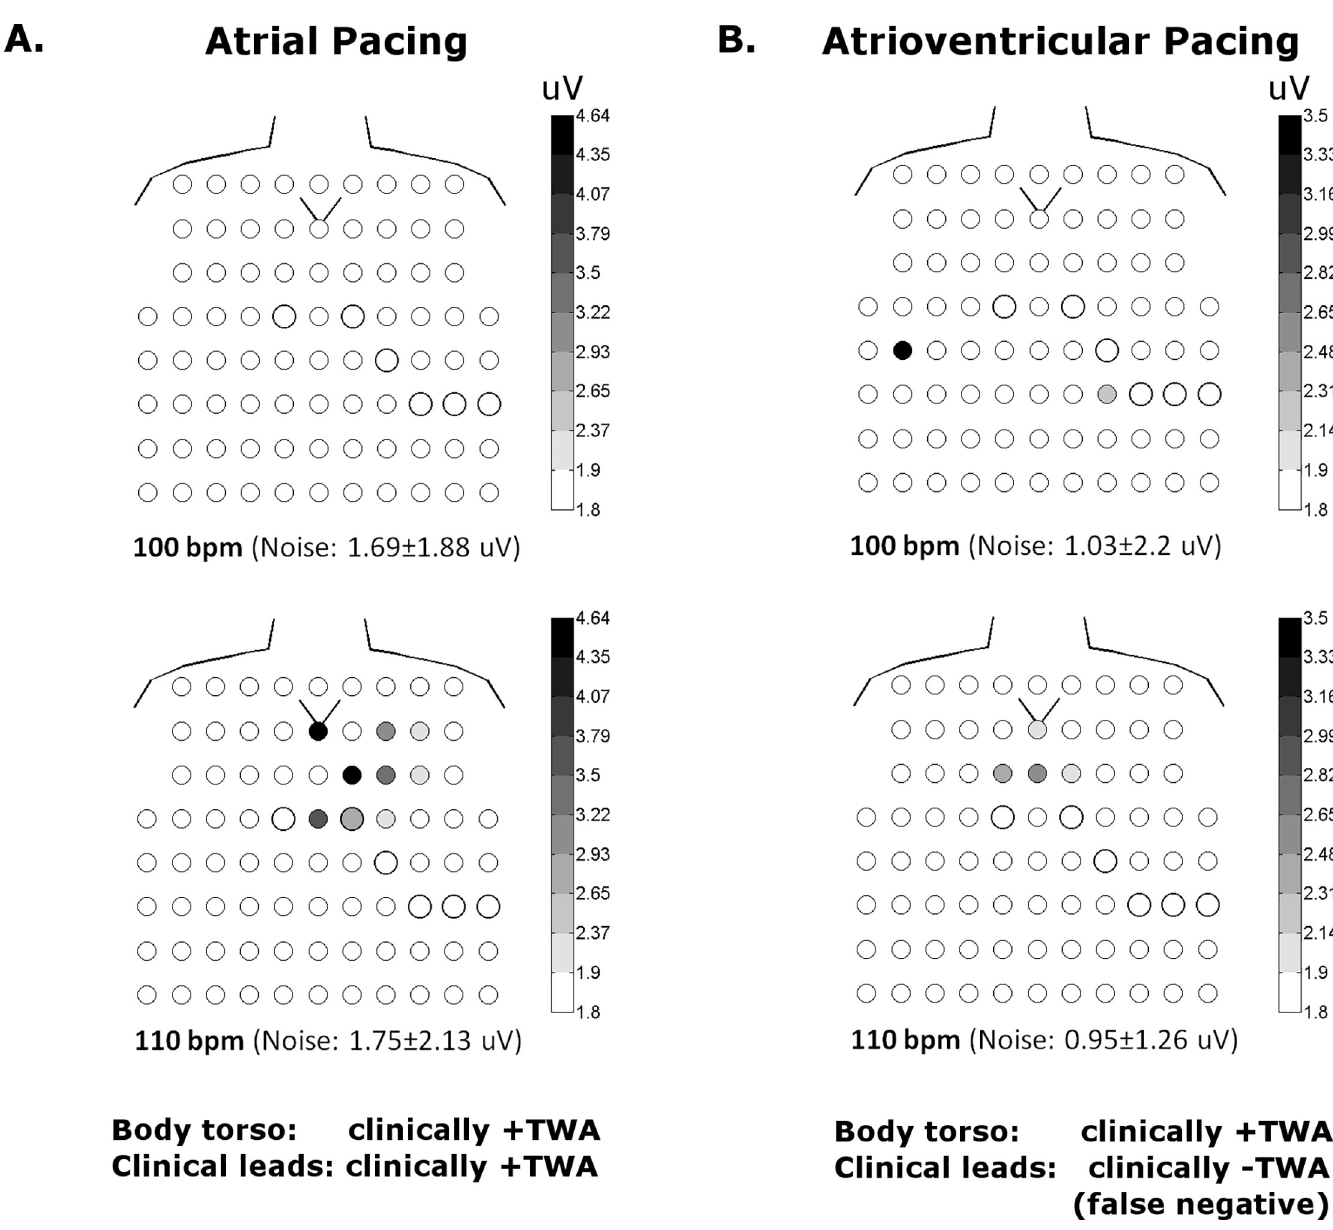
Fig 5. Body torso maps of V alt (uV) in one patient during atrial and atrioventricular pacing. With atrial pacing ( A ), TWA is detected in body torso as well as clinical leads only at 110 bpm. With atrioventricular pacing ( B ), TWA is no longer detected in clinical leads, but remains detectible in body torso. Using clinical leads alone, this patient would be classified as clinically +TWA, but -TWA with atrioventricular